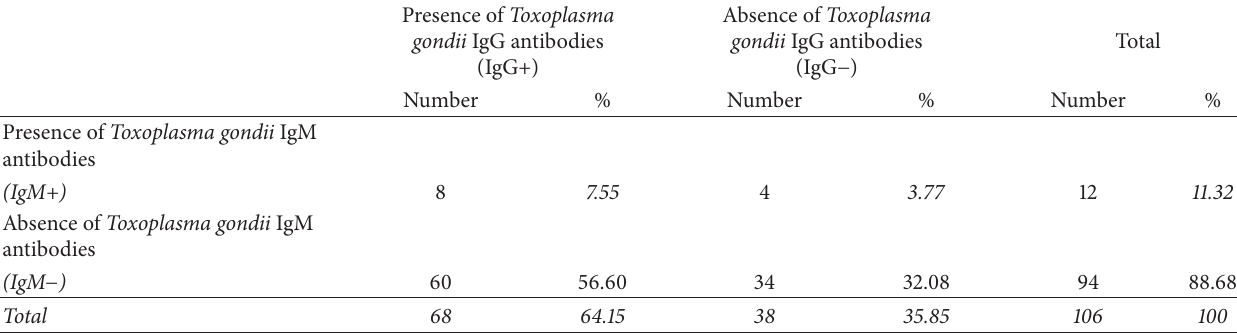
Table 2: Distribution of donors by the immune profile Toxoplasma IgG and IgM.